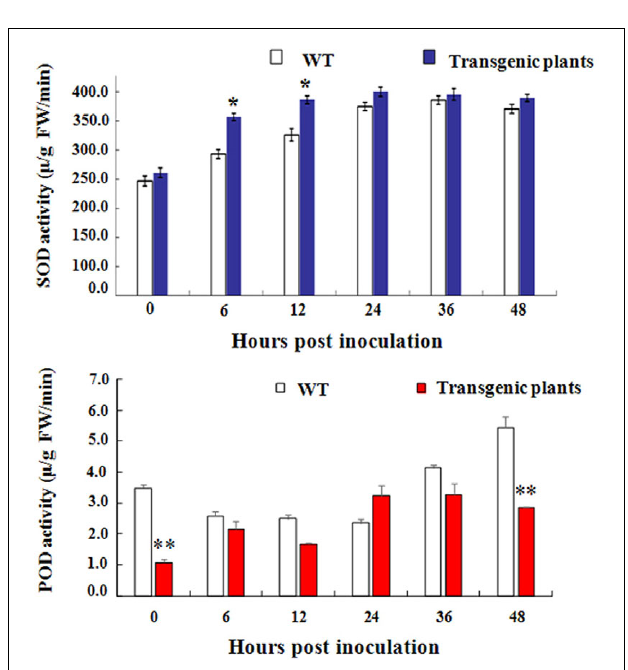
FIGURE 11 | Detection of SOD and POD activity in transgenic Arabidopsis , respectively. The total activities of the antioxidant enzymes SOD (A) and POD (B) in Arabidopsis plants within 48 h after inoculated with V. dahliae . The data are the means ± SD from three independent experiments. The asterisks indicate statistically significant differences between the transgenic and control plants ( ∗ P < 0.05; ∗∗ P < 0.01, Student’s t